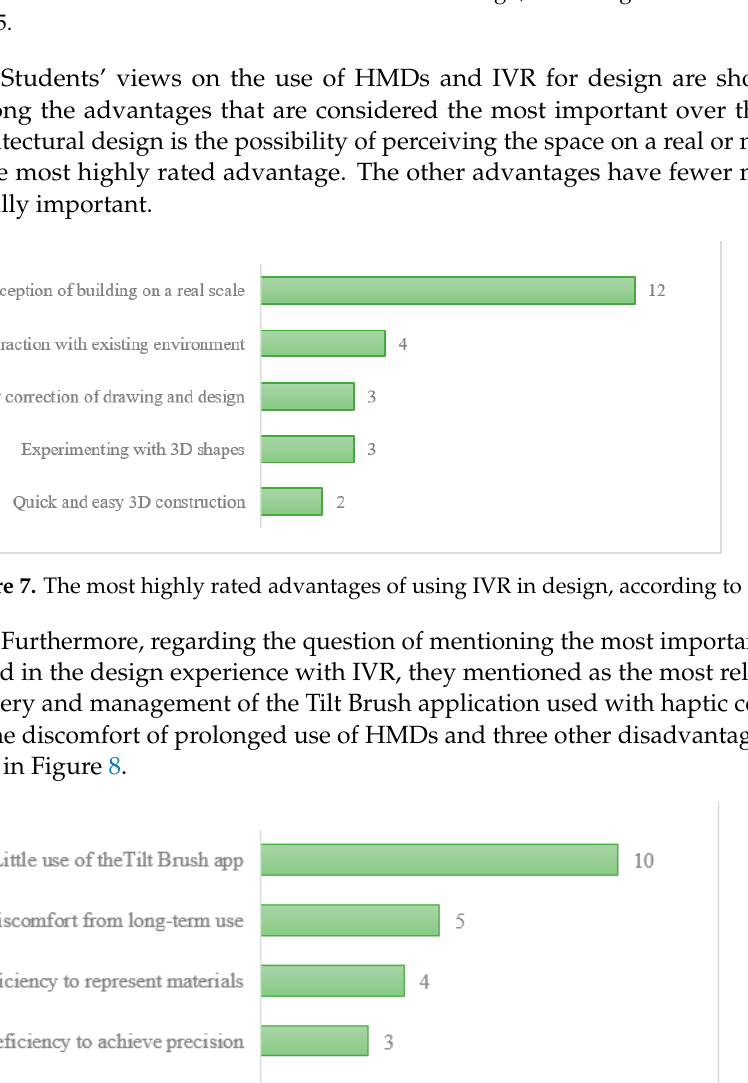
Figure 8. The most highly rated disadvantages of using IVR in design, according to students.